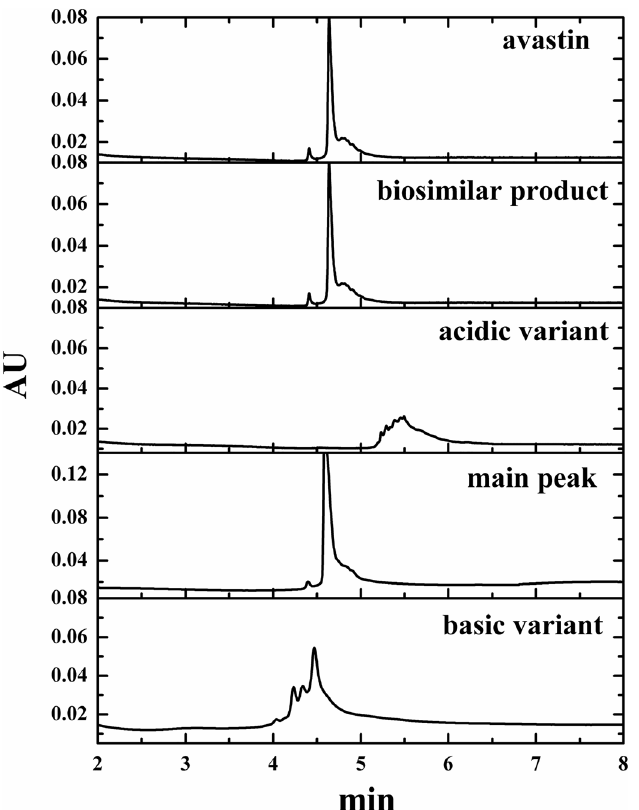
Fig 2. Charge variants of mAbs, biosimilar product and avastin profile obtained by CZE analysis.